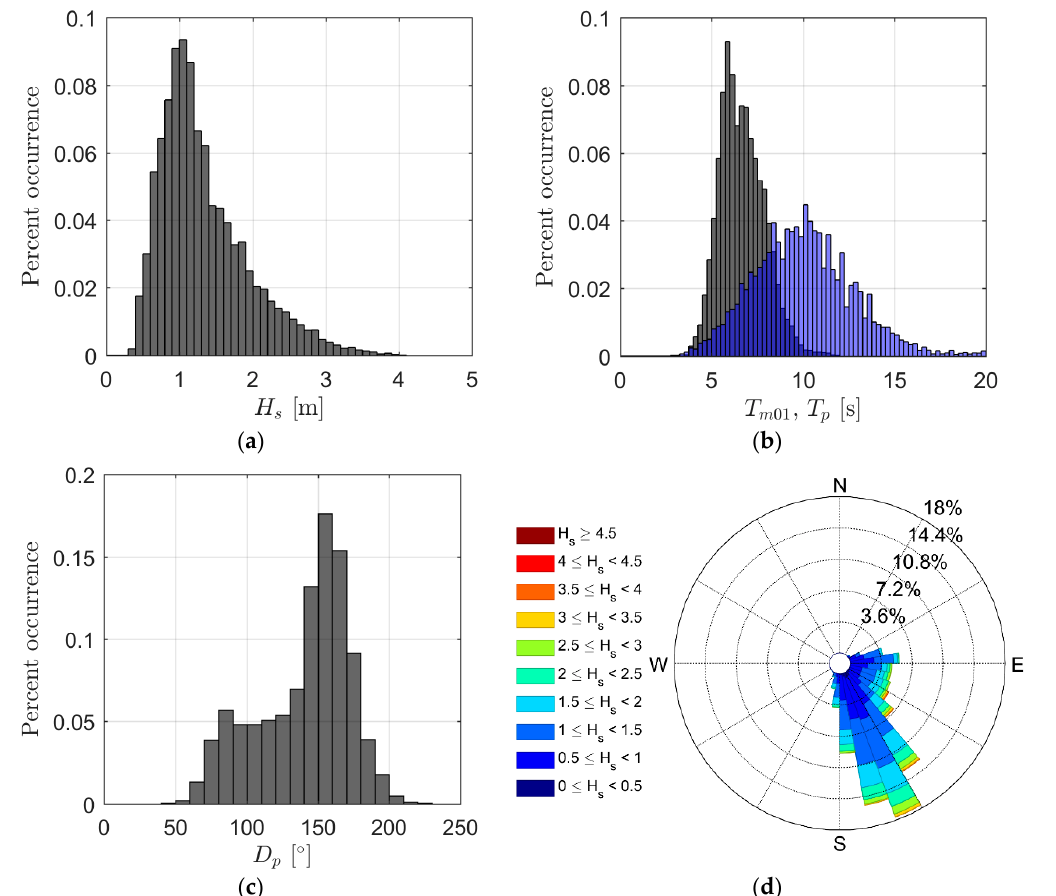
Figure 3. Local wave conditions at the site: histograms of percent occurrence for ( a ) significant wave height ( H s ), ( b ) spectral mean wave period based on the first positive moment of the energy spectrum ( T m 01 ; grey bars) and spectral peak wave period ( T p ; blue bars), and ( c ) peak wave direction ( D p ); and ( d ) a wave rose of H s . See Figure 1c for wave buoy location relative to the rock platform. Data are for the period 6 December 2016 to 30 October 2017.